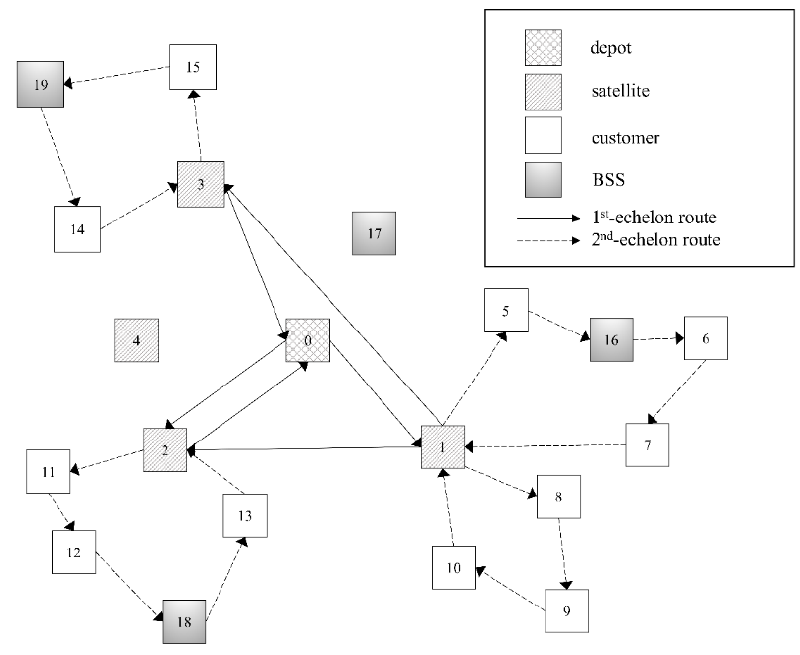
Figure 1. Illustration of 2E-EVRPTW-BSS.